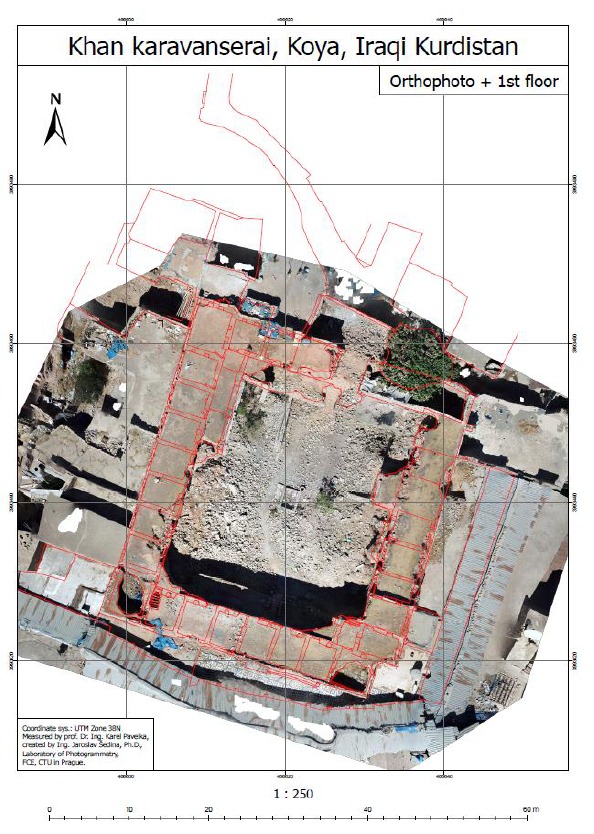
Figure 10. Orthophoto map with a vector layer of the 1 st floor